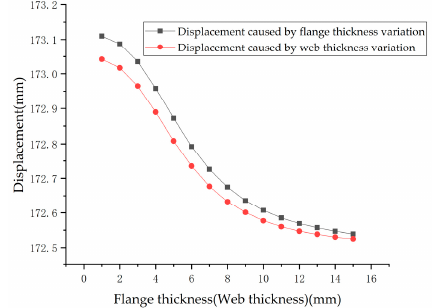
Figure 6. Sensitivity curve of B M plate thickness.